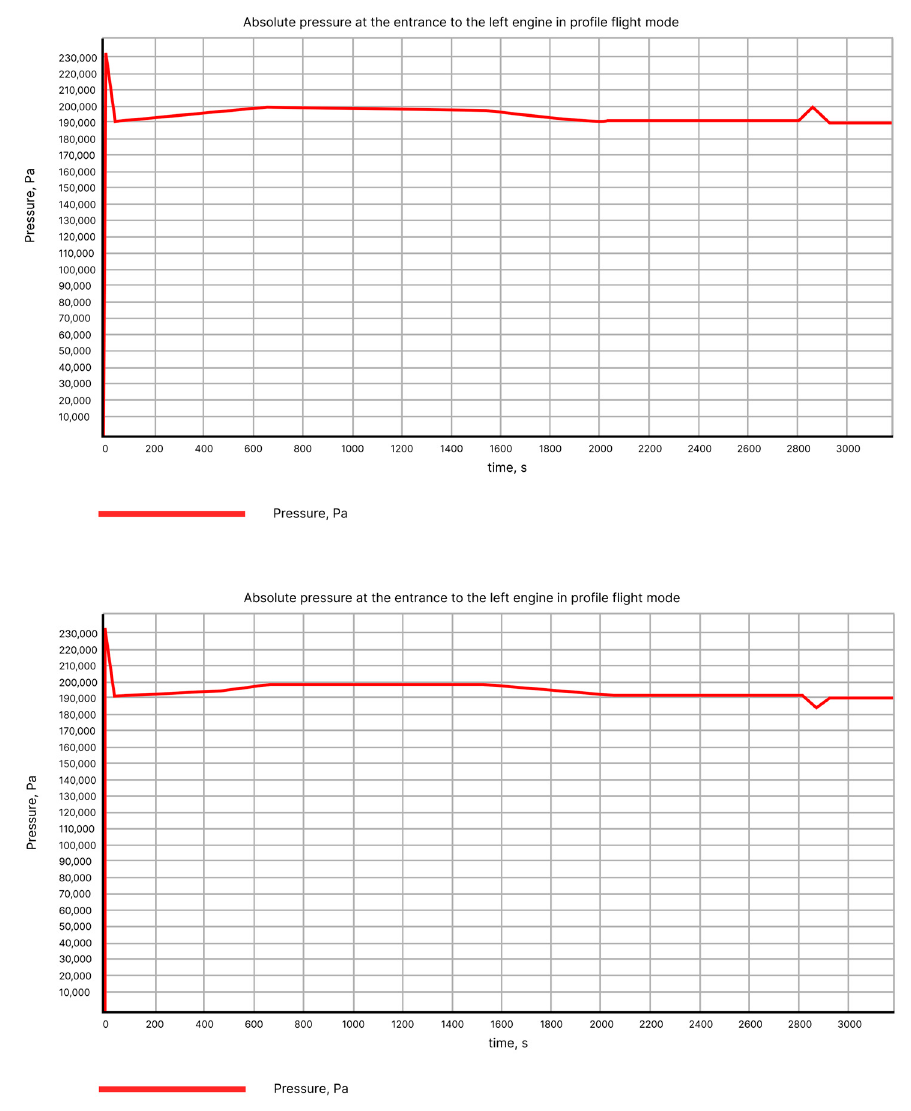
Figure 9. Absolute pressure at an inlet to left and right engines in profile flight mode. Table 4. Weighted coefficients of objective